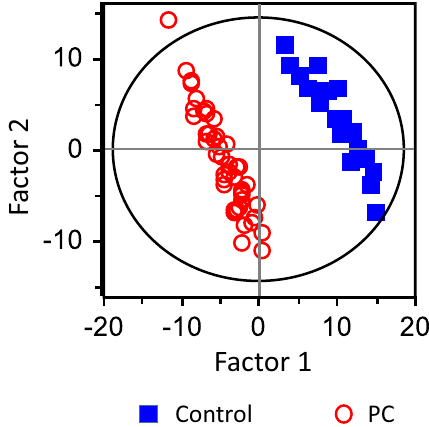
Figure 1. Plot prepared using FID STFT data comparing controls and patients with pancreatic cancer (PC). Blue closed squares represent controls and red open circles represent patients with PC ( R 2 = 0.989 and Q 2 = 0.948).